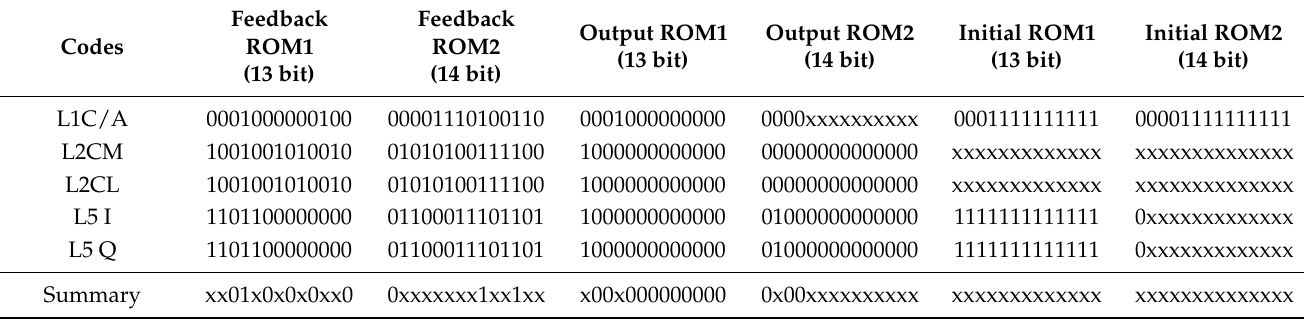
Table 2. The fixed parameters of code generators for GPS signals.